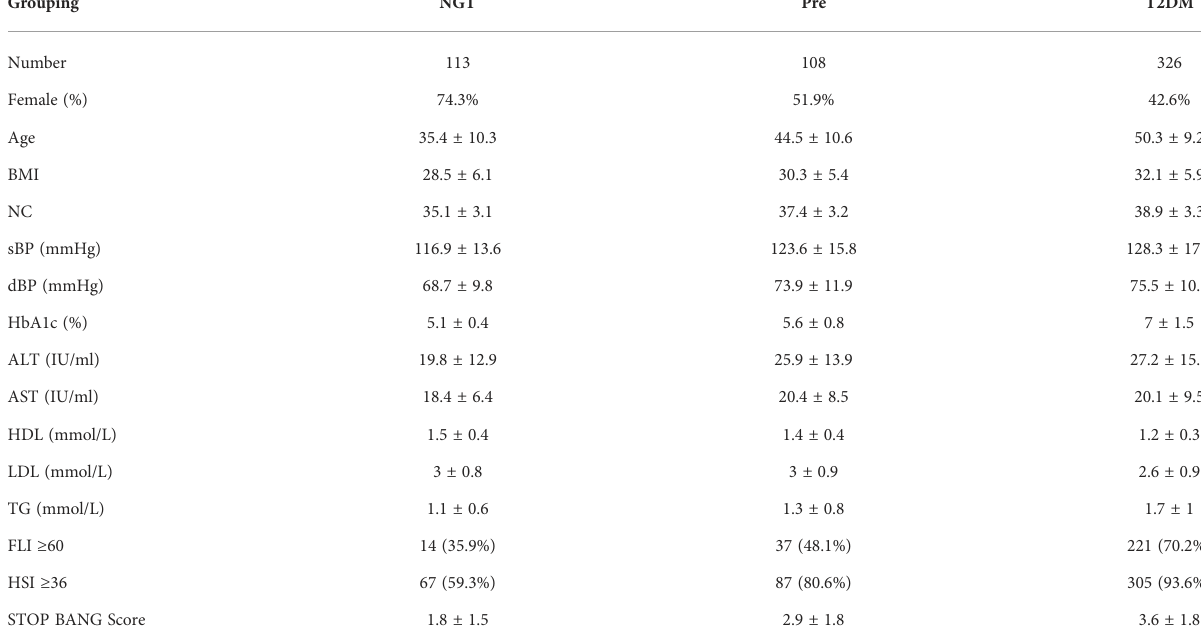
TABLE 1 Baseline characteristics of participants included in statistical analysis. Values are presented as mean ± standard